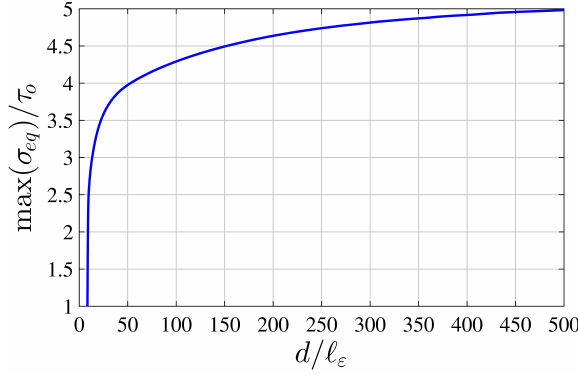
Figure 6: Size effect exhibited by the global maximum max( σ eq ) that appears over the entire lithiation